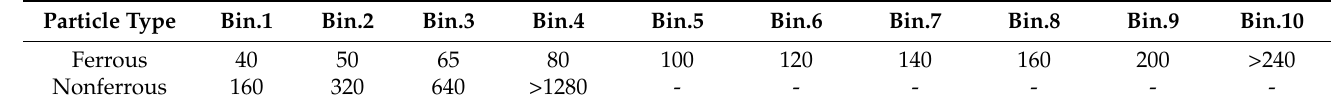
Table 3. Ferrous and nonferrous particle size ranges (average diameter, µ m).